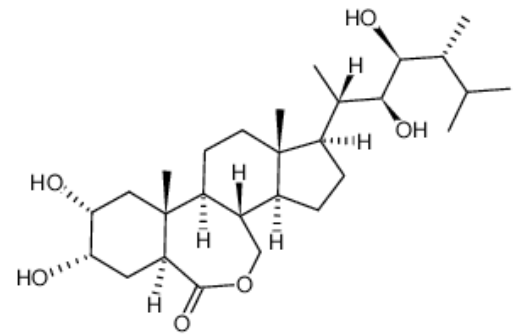
Fig. 1: The structure of 24- epi brassinolide (https://www.chemsrc.com/en/